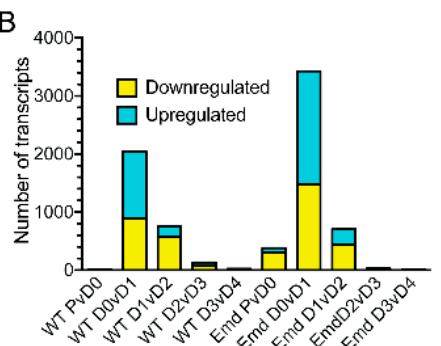
Figure 2. The coordinated temporal expression of thousands of transcripts was altered at each ‘step’ during differentiation of emerin-null myogenic progenitors. ( A ) The number of differentially expressed transcripts between wildtype and emerin-null progenitors at each day during differentiation are shown. ( B ) Comparison of differentially expressed transcripts between consecutive days of differentiation for wildtype (WT) or emerin-null (Emd) myogenic progenitors. P, proliferating cells, D0, day 0; D1, day 1; D2, day 2; D3, day 3; D4, day 4.